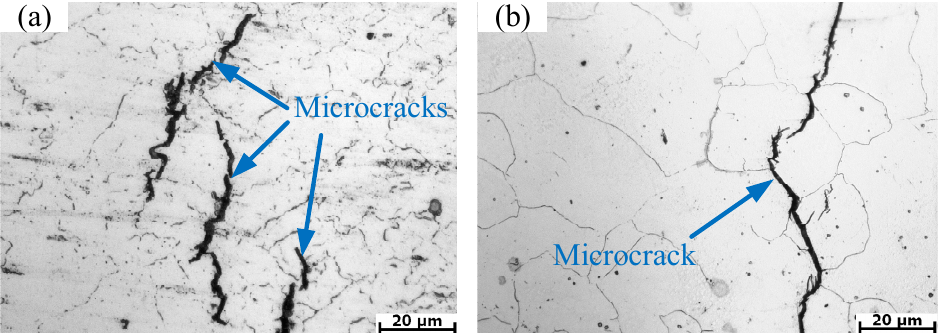
Figure 12. Unstable microstructure of X12CrMoWVNbN10-1-1 alloy steel under various conditions: ( a ) 1050 °C/0.1 s − 1 ; ( b ) 1200 °C/5 s − 1 .